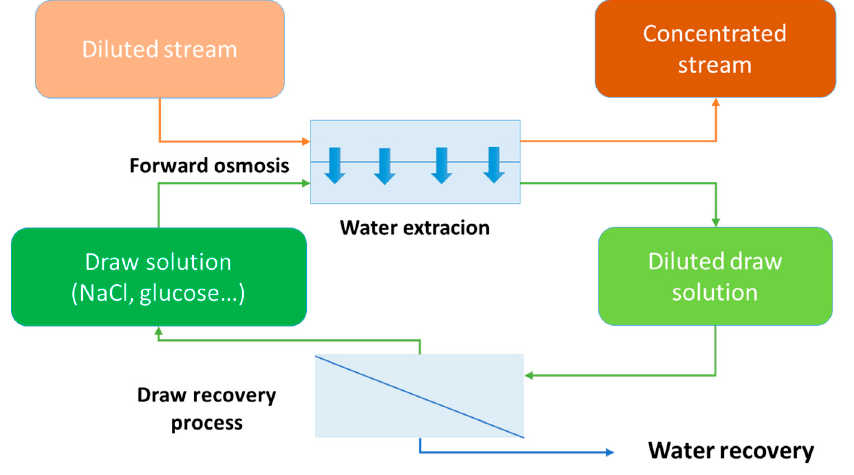
Figure 1. Basic principles of forward osmosis as concentration process.